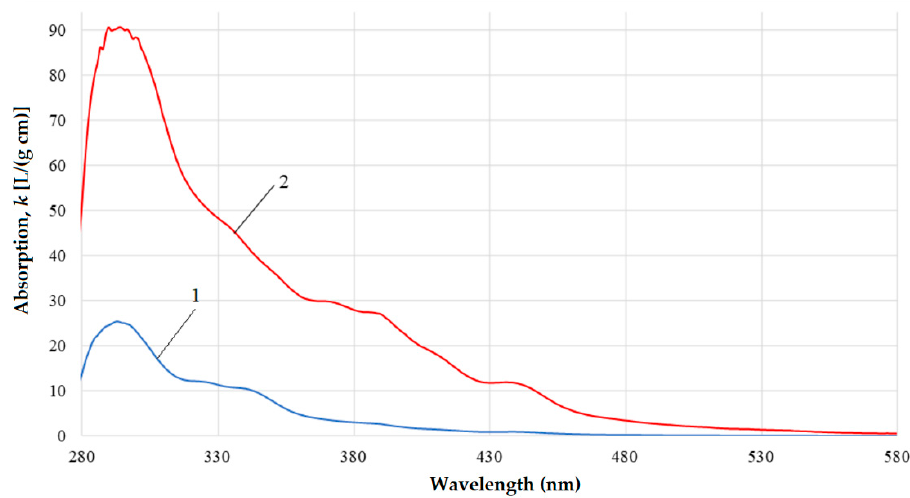
Figure 5. (Line 1) UV-vis spectra of the original gasoil versus (Line 2) its fraction with boiling point higher than 450 ◦ C.